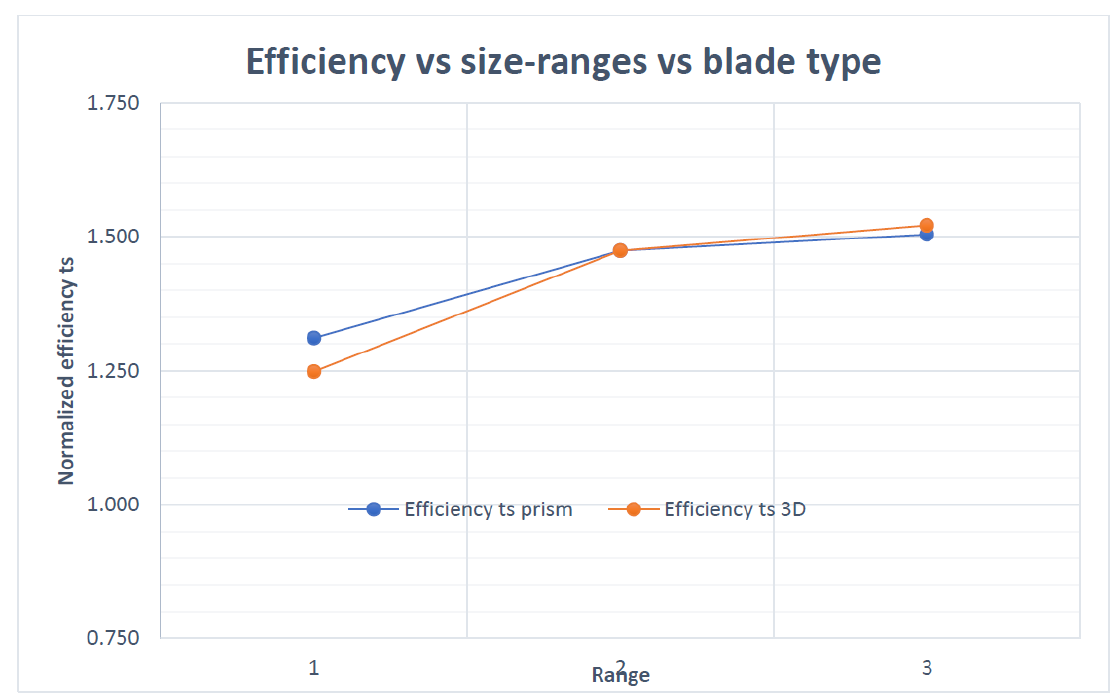
Figure 22. Inertia vs. size ranges and blade types.